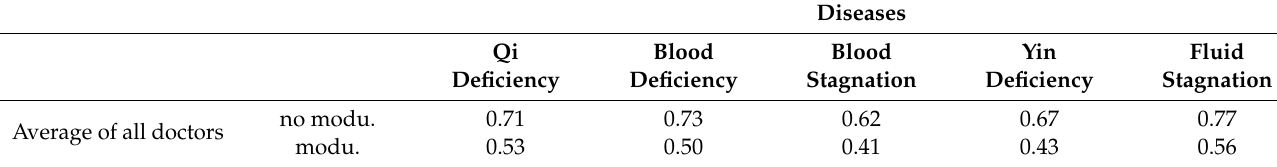
Table 6. Root mean squared error between the correct value (using average of values assigned by each Kampo doctor) and the value estimated by support vector regression for each disease using data with no modulation (no modu.) and modulation